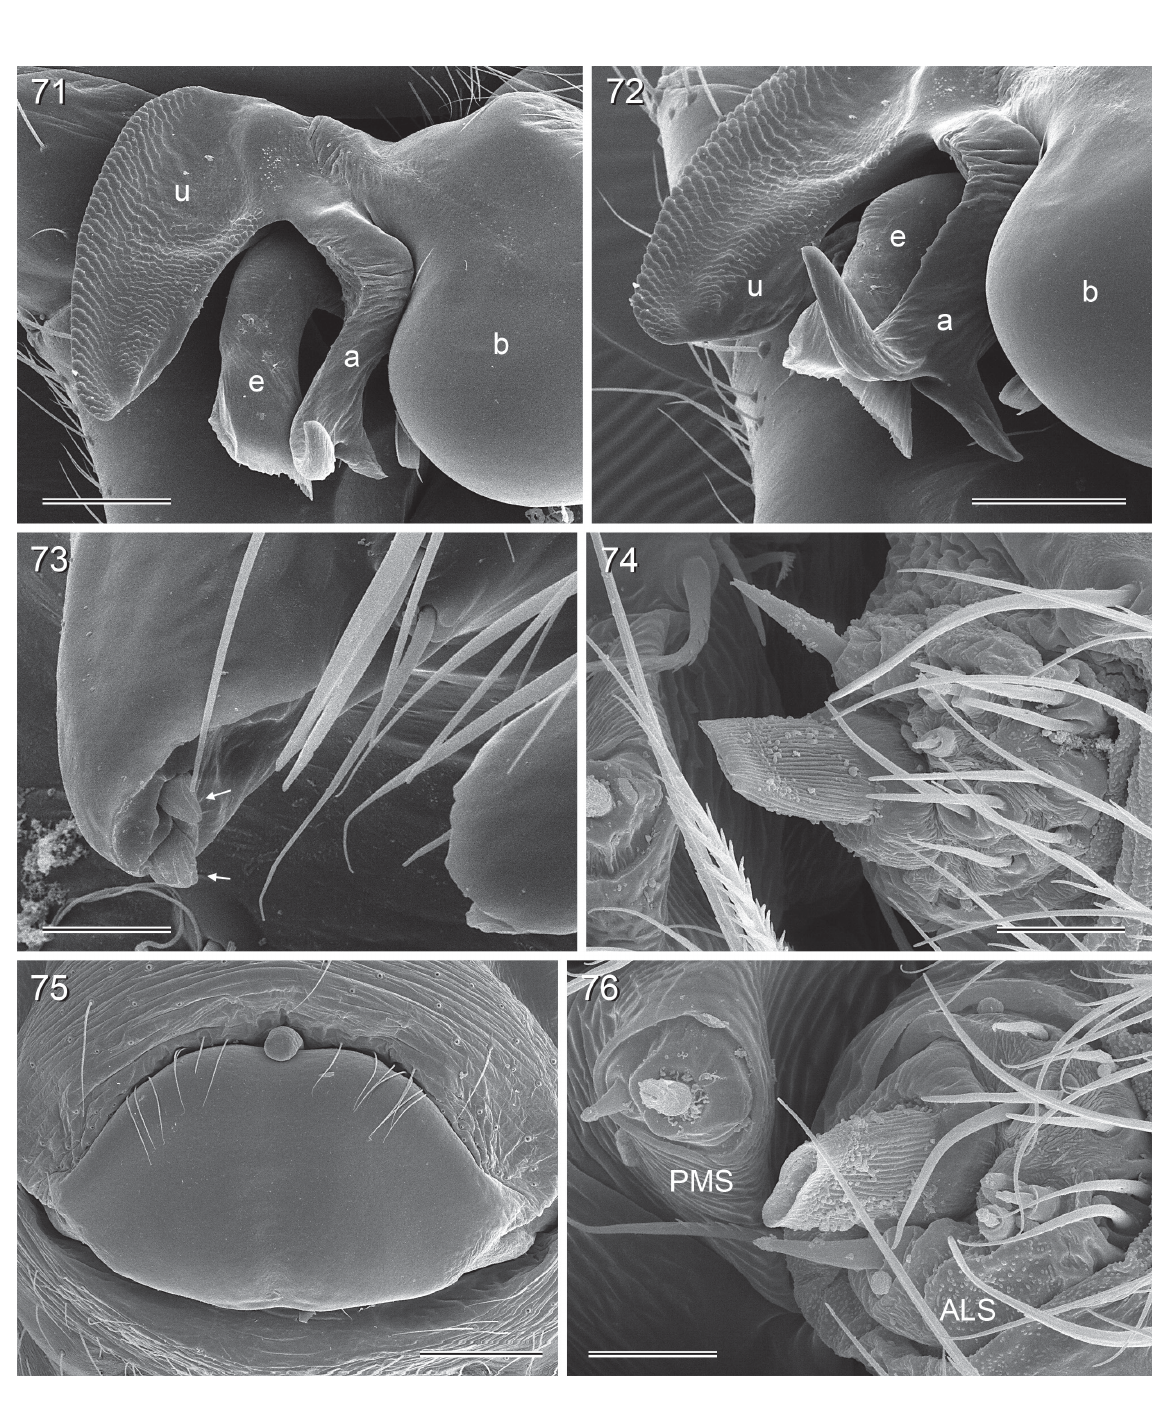
Figs 71–76. Pholcus baguio Huber, sp. nov., ZFMK Ar 15507–08. 71–72 . Left genital bulb, prolateral and prolatero-distal views. 73 . Male distal cheliceral apophysis (arrows point at modified hairs). 74 . Male ALS. 75 . epigynum. 76 . Female ALS and PMS. Scale lines: 71–72, 75 = 200 µm; 73–74, 76 = 20